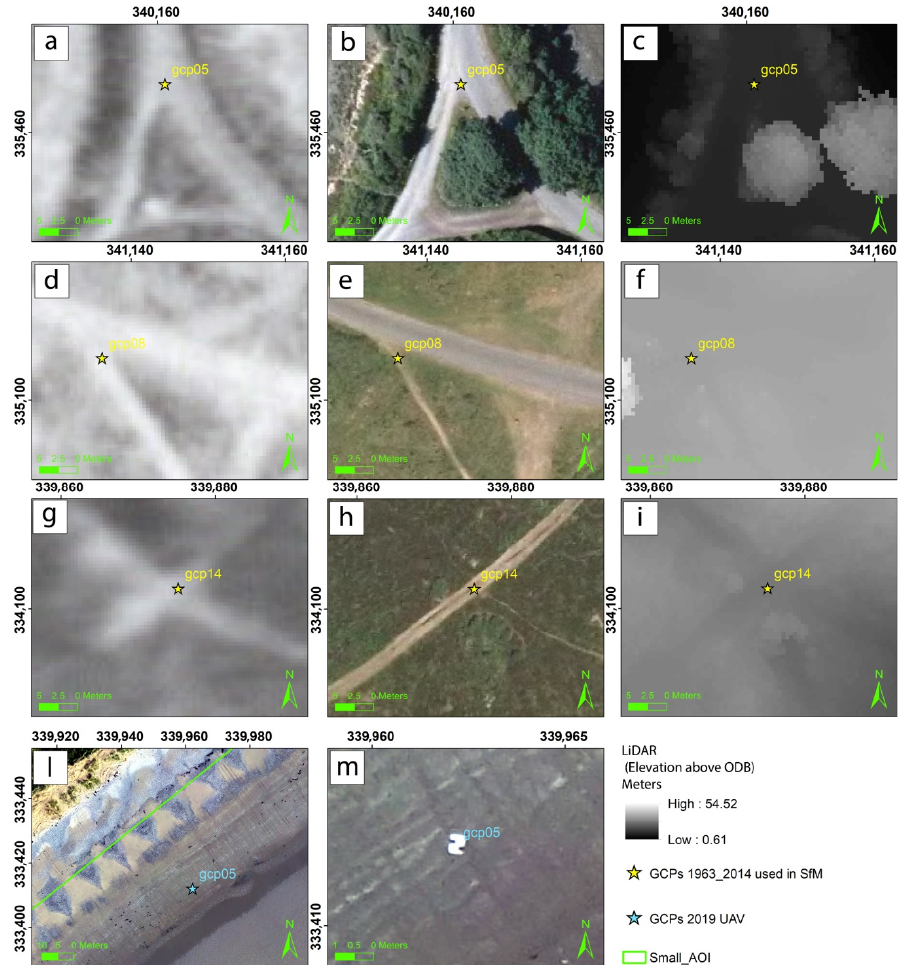
Figure 3. Examples of co-registration ground control points (GCPs) in the historical and recent datasets. GCP05 in the 1963 aerial photograph ( a ), 2014 orthophoto ( b ), and 2014 light detection and ranging dataset ( c ). GCP08 in the 1963 aerial photograph ( d ), 2014 orthophoto ( e ), and 2014 light detection and ranging dataset ( f ). GCP14 in the 1963 aerial photograph ( g ), 2014 orthophoto ( h ), and 2014 light detection and ranging dataset ( i ). GCP05 in the 2019 unmanned aerial vehicle (UAV) image ( l ) and its enlargement ( m ). Note that GCP05 shown in ( l , m ) is not the same one shown in ( a – c ). Aerial photography images from 1963 and 2014 were provided by the Ordnance Survey of Northern Ireland. ODB stands for Ordnance Datum Belfast.